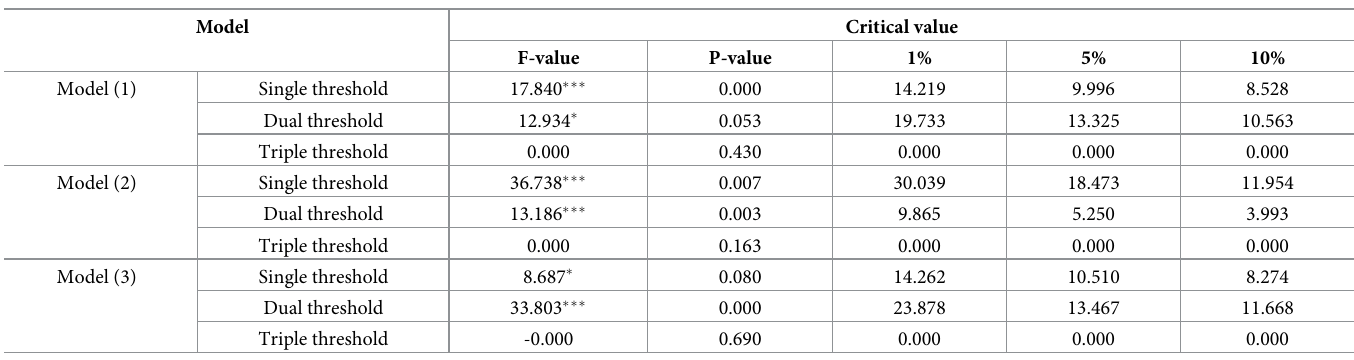
Table 1. Test of threshold effect.